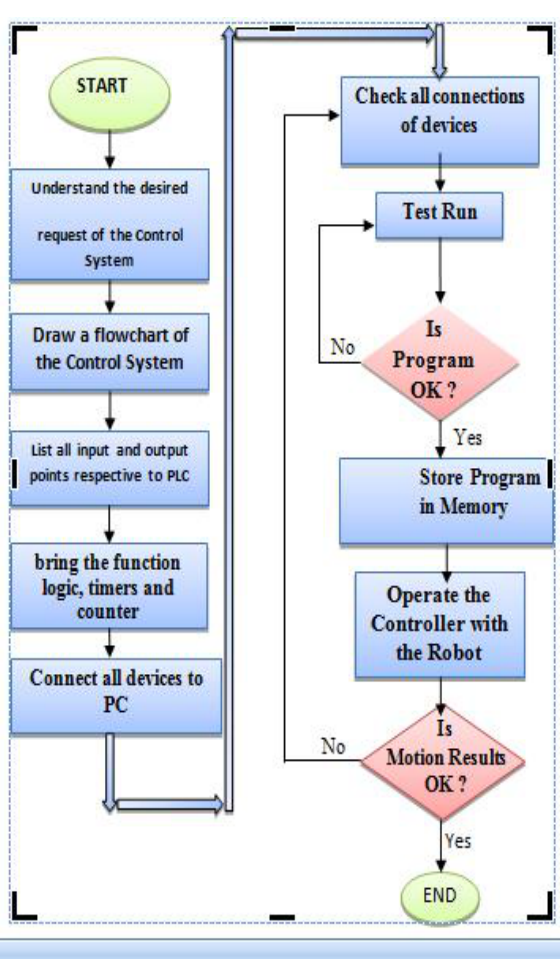
Fig. 11. Flowchart of controller design for SCARA robot.